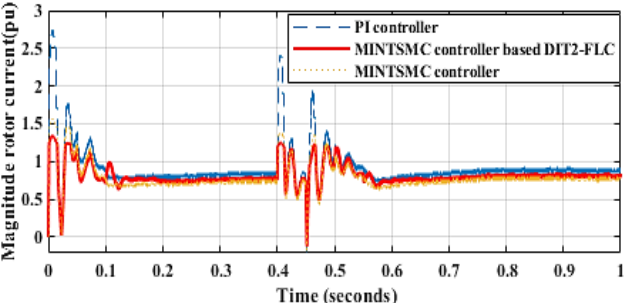
Figure 16. Magnitude rotor current of the DFIG system via the PI controller, MINTSMC controller, MINTSMC controller-based DIT2-FLC.